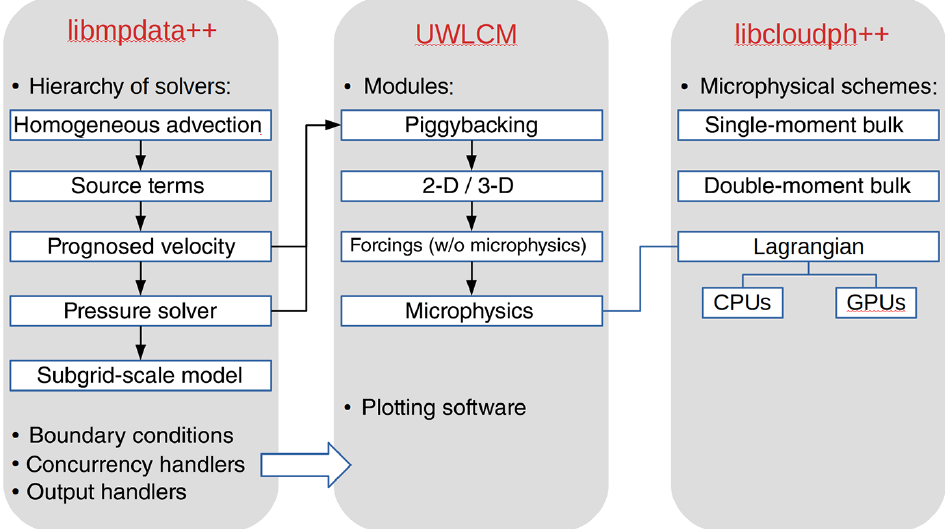
Figure C1. Schematic depiction of the structure of the code of UWLCM, libmpdata++ and libcloudph++. Black arrows denote inheritance between